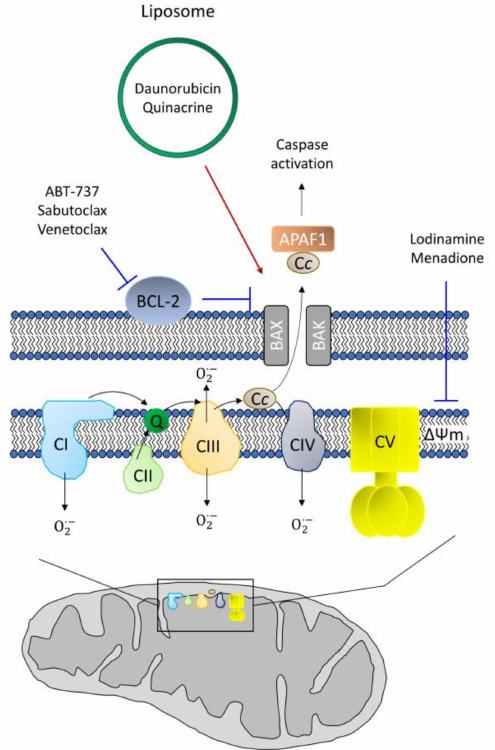
Figure 4. Summary of intrinsic apoptotic pathway. BCL-2, as antiapoptotic protein, inhibits the formation of pores by BAX / BAK that allow cytochrome c release to the cytoplasm, where it interacts with Apaf-1 to constitute apoptosome, allowing caspase cascade. Drugs targeting apoptosis comprise dissipaters of mitochondrial membrane potential ( ∆Ψ m) or BCL-2 inhibitors (blue lines) or molecules enhancing formation of BAX / BAK pores (red